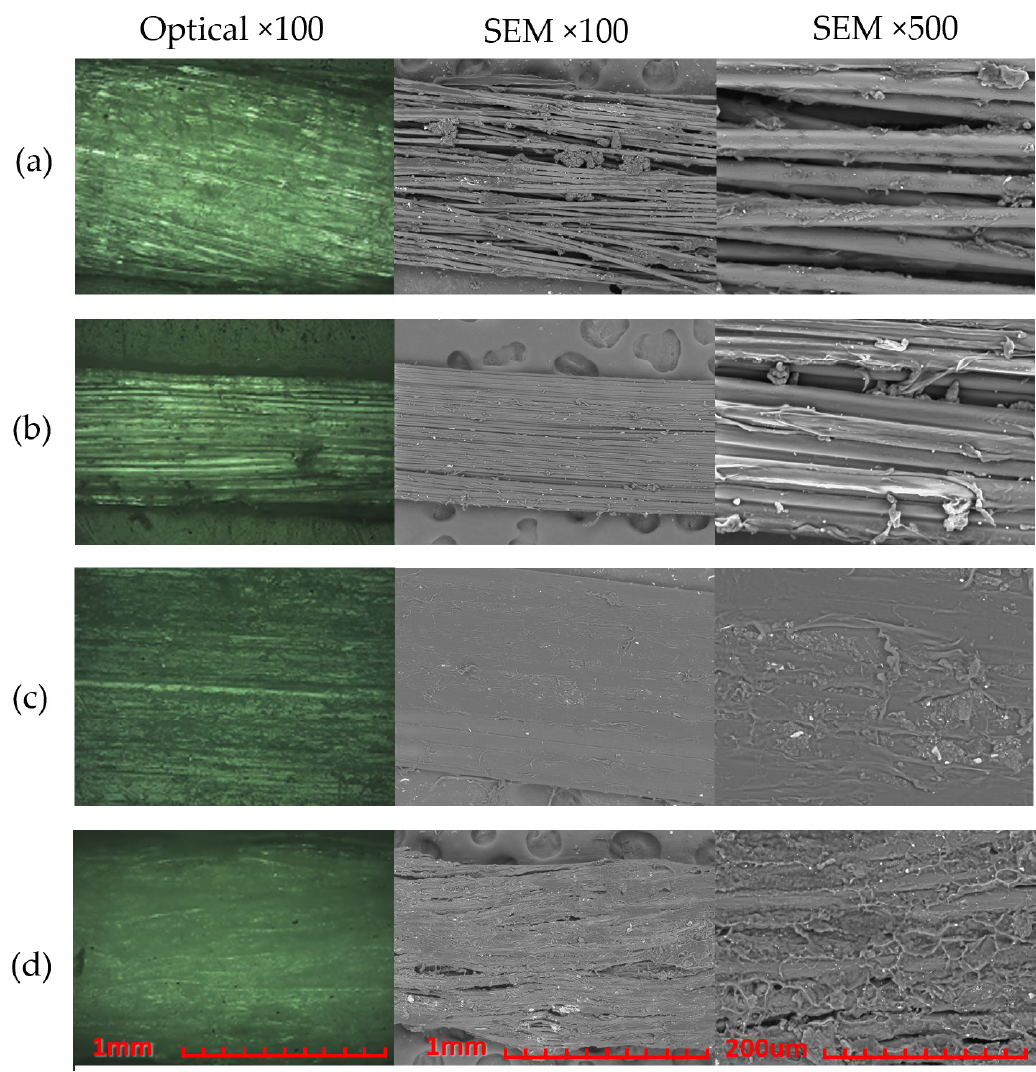
Figure 3. Optical and SEM images of untested flosses: ( a ) Lacalut; ( b ) Oral B Essential; ( c ) Oral B Satin; ( d ) Sensodyne.